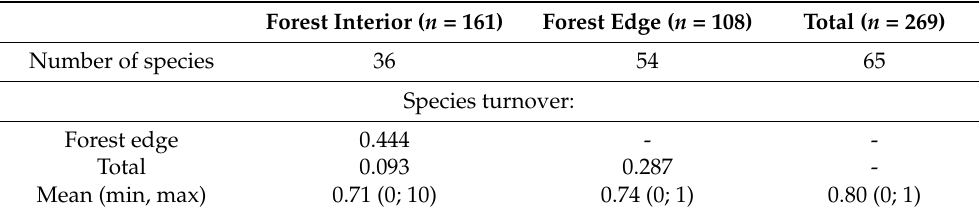
Table 2. Species richness within and among the types of transects according to Whittaker’s species turnover.